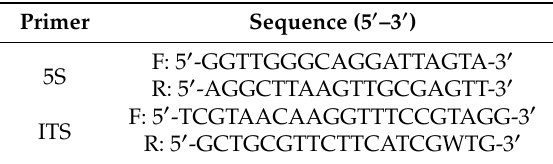
Table 1. Sequences of primer pairs for Ulva prolifera